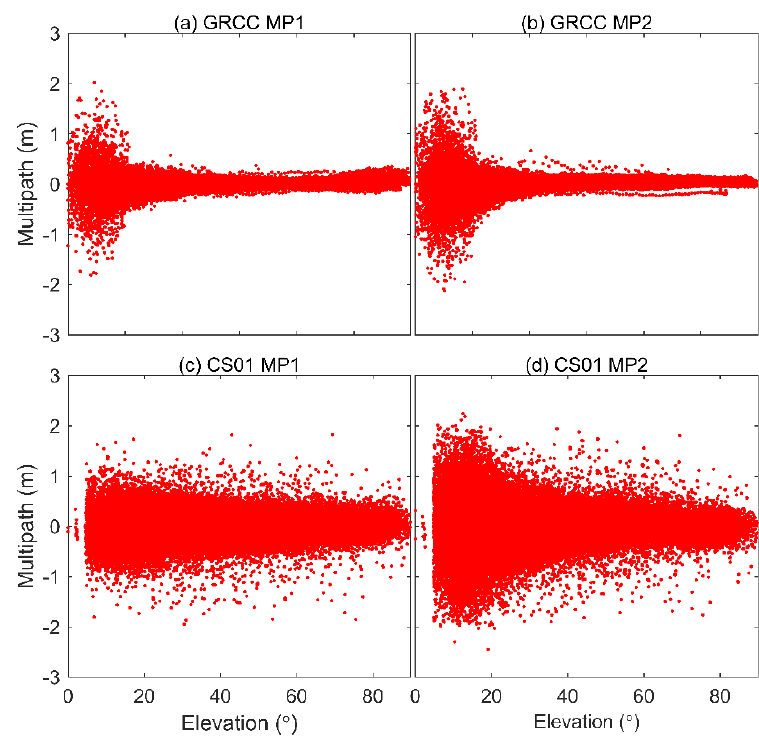
Figure 2. Multipath error variations with elevation for GRCC and CS01.